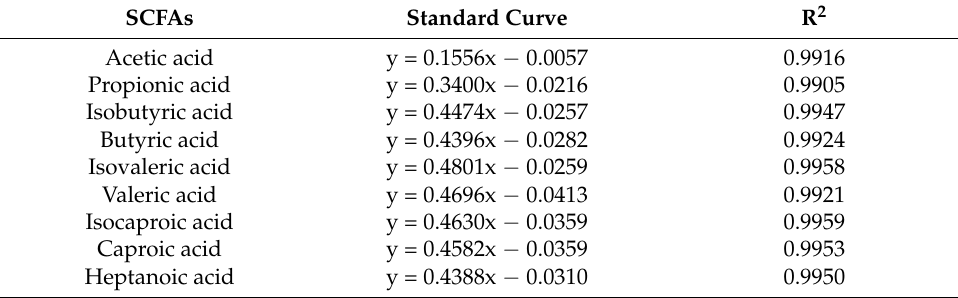
Table 2. Standard curves of SCFAs in mixed acid